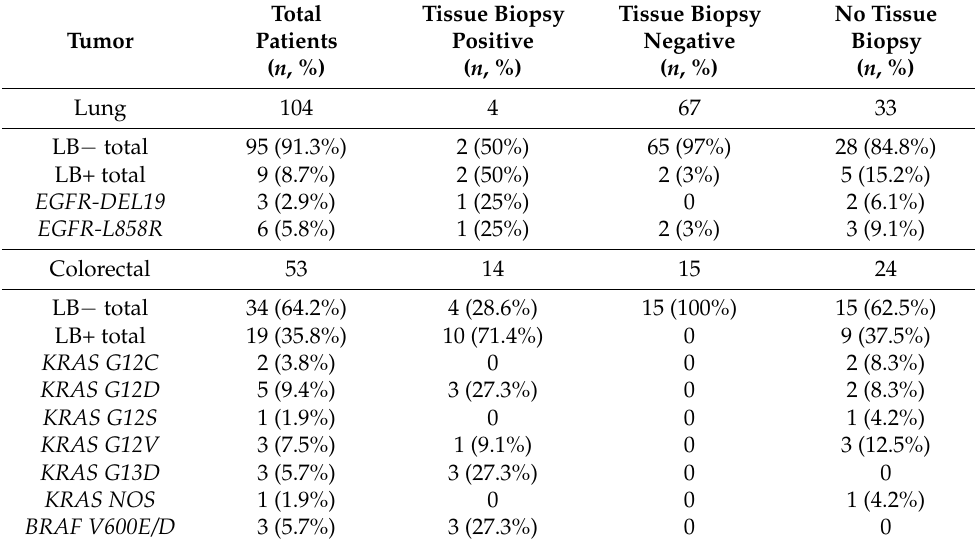
Table 3. Lung and colorectal cancer patients under investigation for genomic mutations identified with ctDNA liquid biopsy and treatment